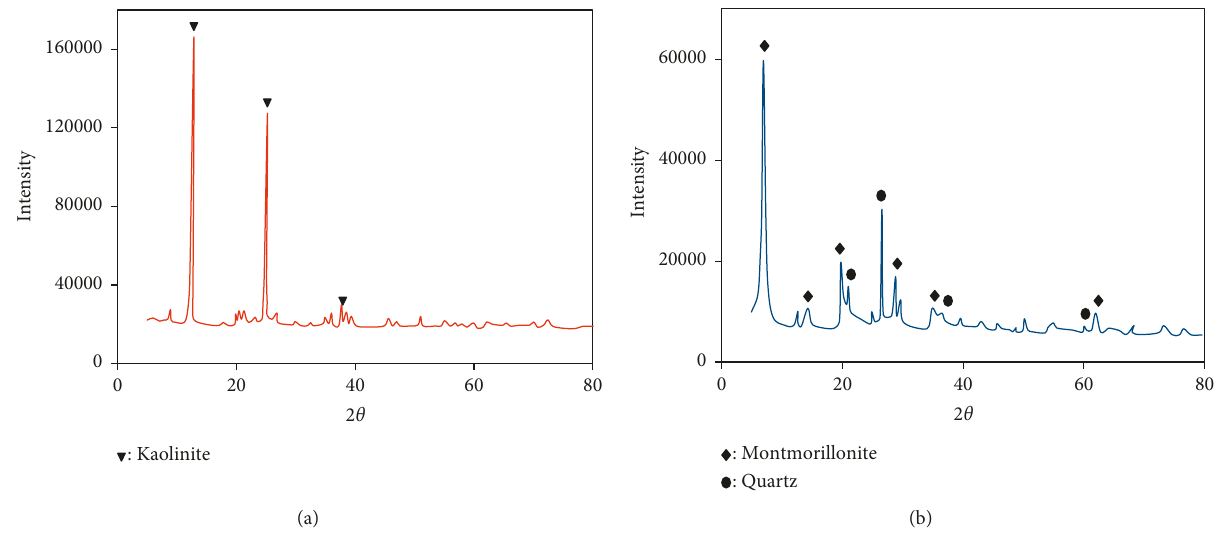
Figure 2: XRD analysis of (a) kaolin and (b)